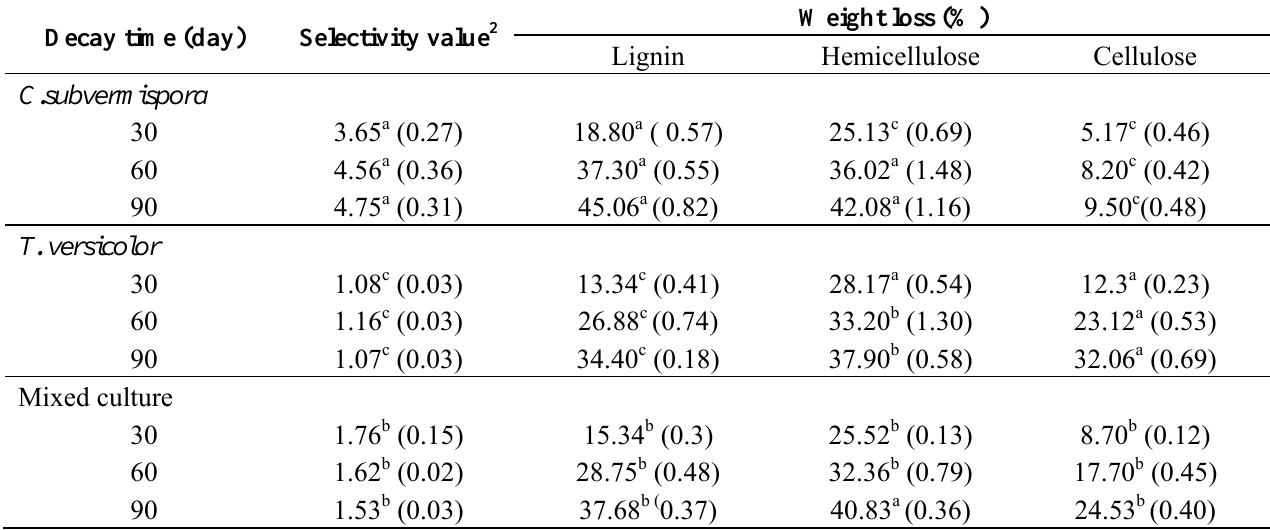
Table 1. Component losses of rubberwood pretreated by white rot fungi for 30, 60, and 90 days 1